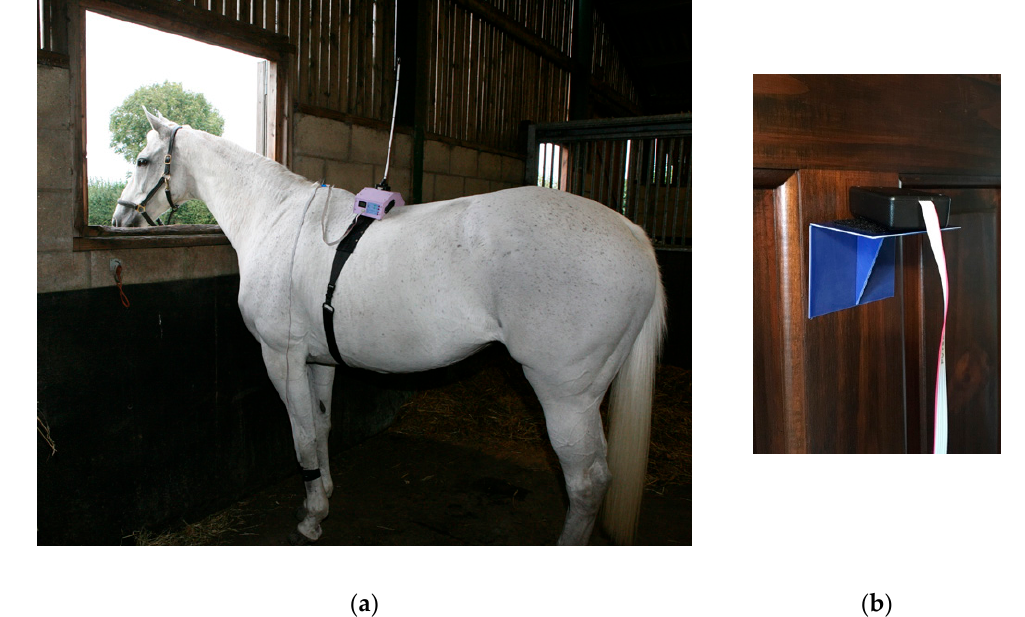
Figure 5. ( a ) Thermal unit with receiver mounted on aerial on a horse’s back. ( b ) Transmitter placed high on stable wall.